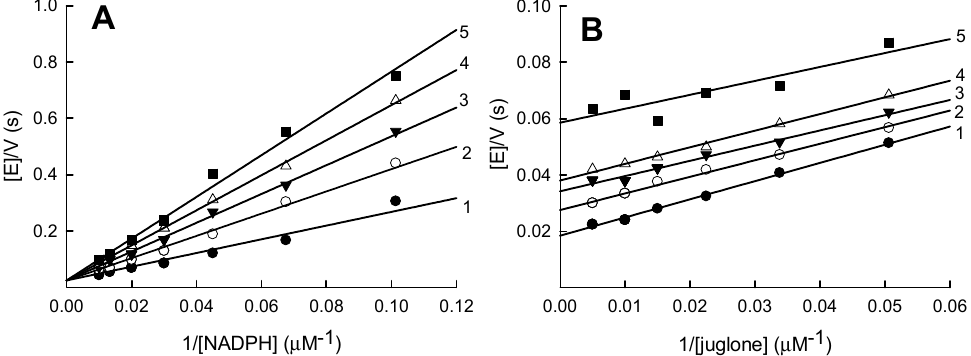
Figure 6. Inhibition of the juglone reductase reaction of Pf FNR by NADP + . ( A ) Inhibition at varied NADPH concentrations in the presence of 100-µM juglone, and ( B ) inhibition at varied juglone concentrations in the presence of 100-µM NADPH, NADP + concentrations: 0 mM (1), 1.0 mM (2), 2.0 mM (3), 3.0 mM (4) and 5.0 mM (5).